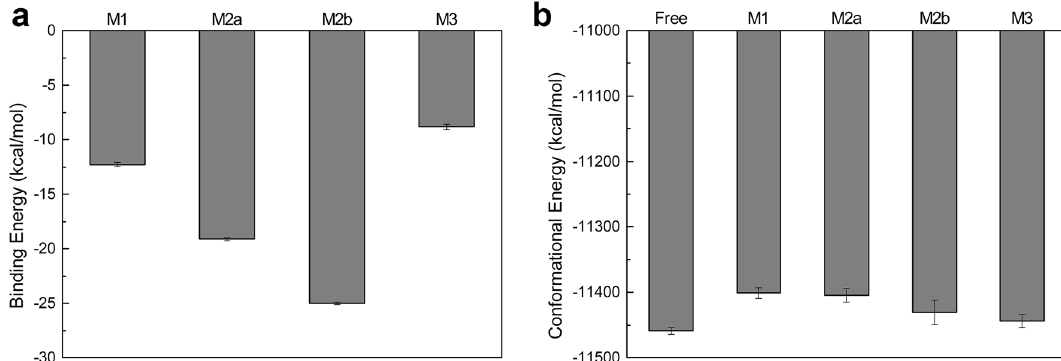
Figure 6. The binding energy of M1 – M3 to CYP2J2 ( a ) and conformational energy of CYP2J2 in complex with M1 – M3 ( b ). For comparison, conformational energy for the free CYP2J2 was also calculated. M2a and M2b denote initially extended and folded conformation of M2 in the binding pocket of CYP2J2,